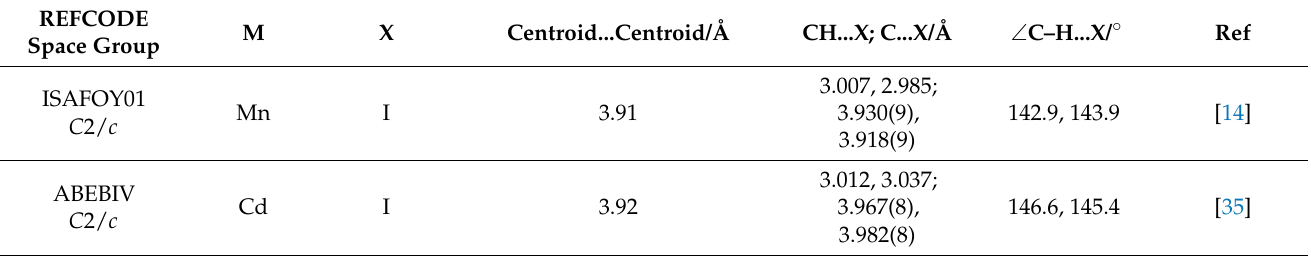
Table 4. Metric parameters for the face-to-face π -stacking and CH...X contacts in the motif in